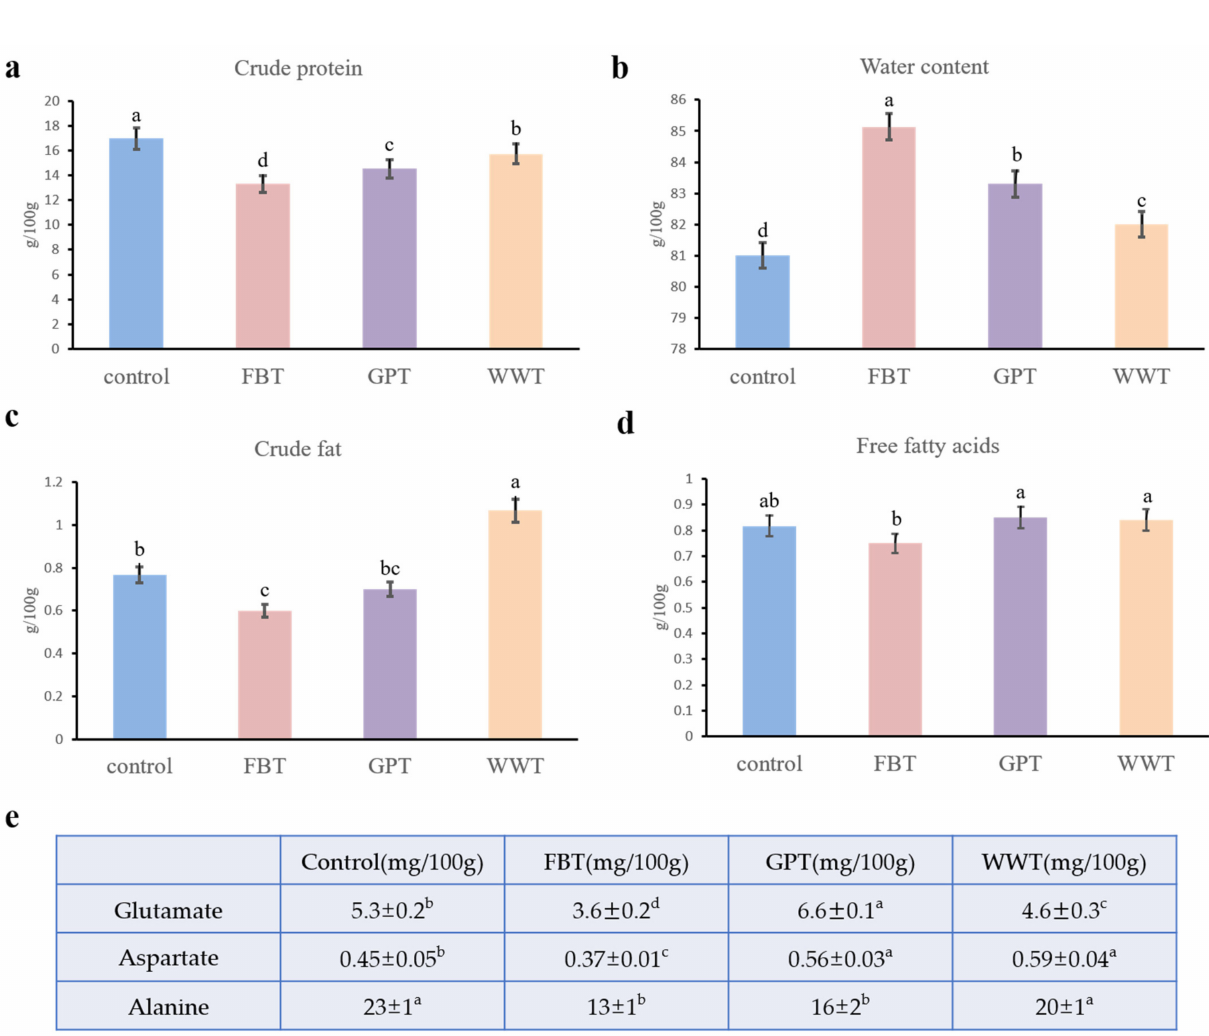
Figure 2. Nutrition composition of grass carp muscle from four culture modes. Statistical analyses were performed using Tukey’s test. FBT, faba bean treatment; GPT, grass powder treatment; WWT, waving water treatment with commercial feed. ( a ) Crude protein; ( b ) Water content; ( c ) Crude fat; ( d ) Free fatty acids; ( e ) free amino acids. Different superscript letters were significantly different ( p <